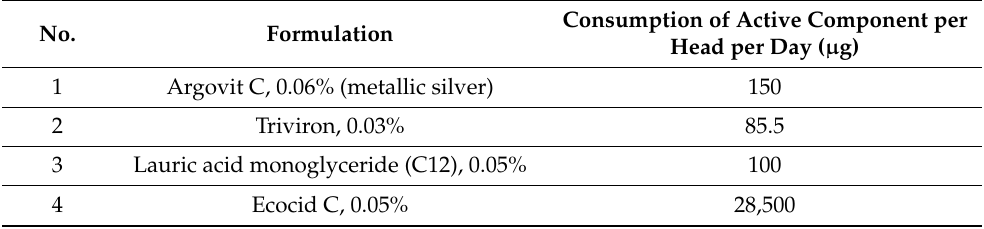
Table 1. Consumption per head per day for studied